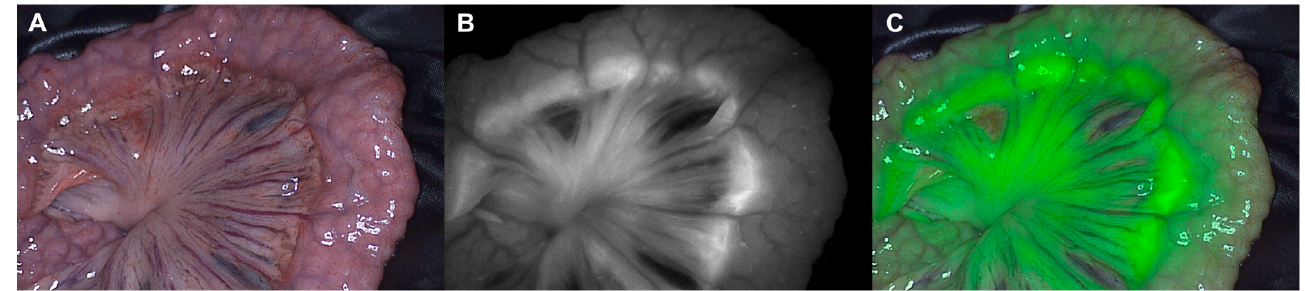
Figure 4. Picture of ascites after 40 min of IV ICG administration. ( A ) The RGB image. ( B ) Fluorescence picture at 800 nm ( C ) Overlay fluorescence picture at 800 nm.